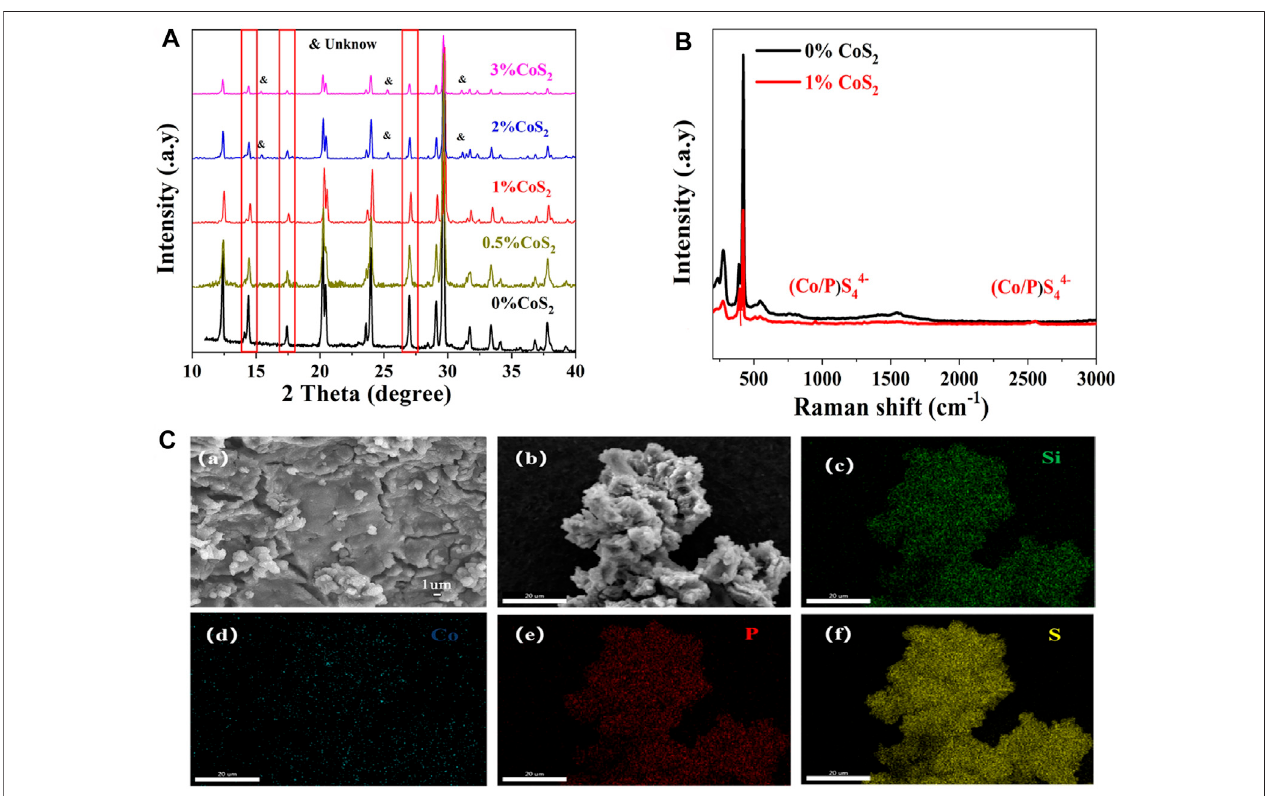
FIGURE 5 | XRD patterns of Li 10.35 Si 1.35-x Co x P 1.65 S 12 with different Co 4+ doping ratios (A) , Raman Spectra of pristine and 1% Co 4+ -doped electrolytes (B) , and SEM and EDS images of 1% Co 4+ -doped Li 10.35 Si 1.35-x Co x P 1.65 S 12 (C)